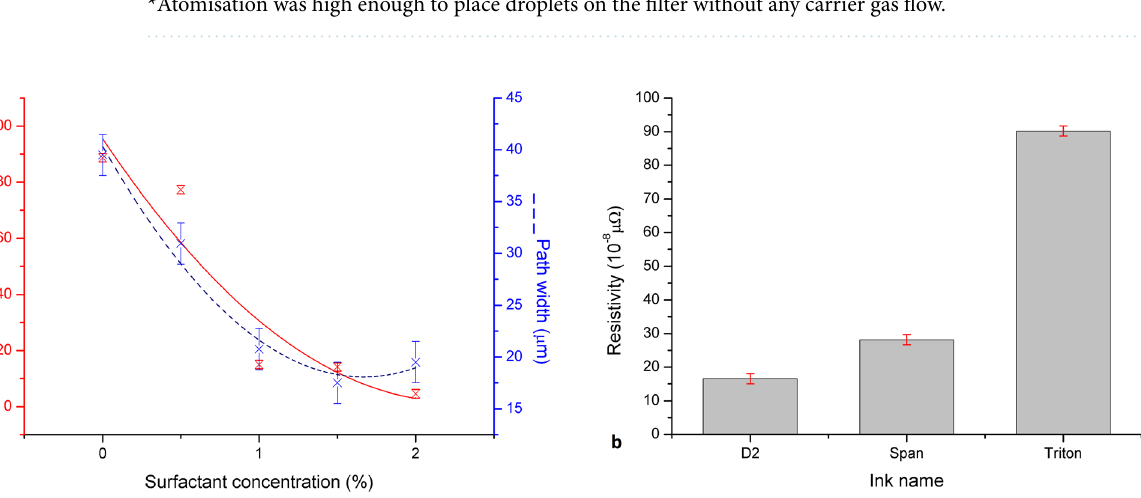
Table 2. Mean value of resistance and width acquire with an optical microscope of 8 printed 15 mm lines. * Atomisation was high enough to place droplets on the filter without any carrier gas flow.